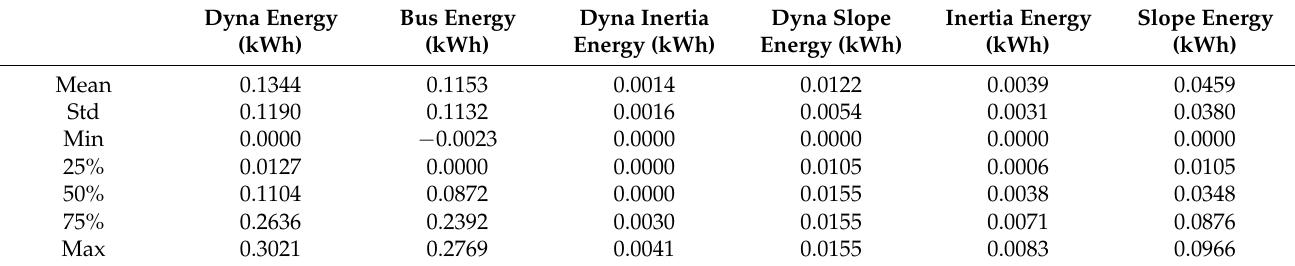
Table 2. Final energy meters test route.